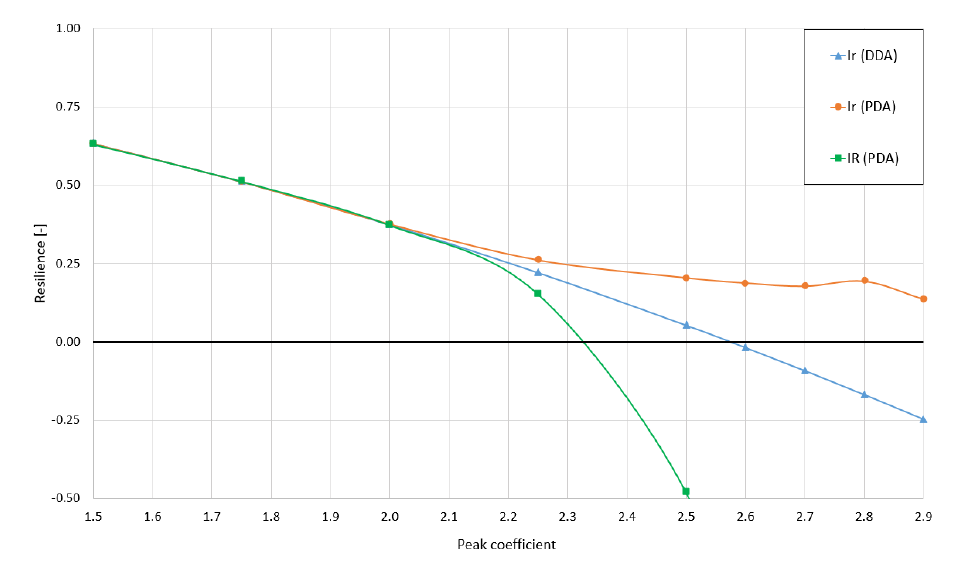
Figure 3. Resilience indices as a function of the peak coefficient P c . The indices were calculated for the peak coefficients listed in Table 1, and then the lines are obtained by an